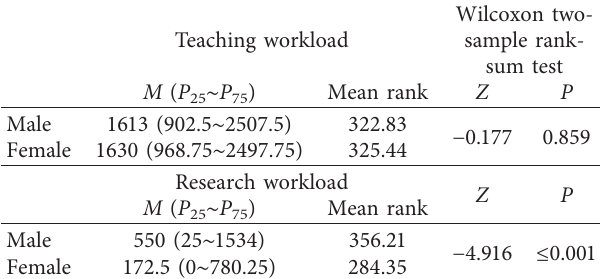
Table 2: Rank-sum test of overall teaching and research